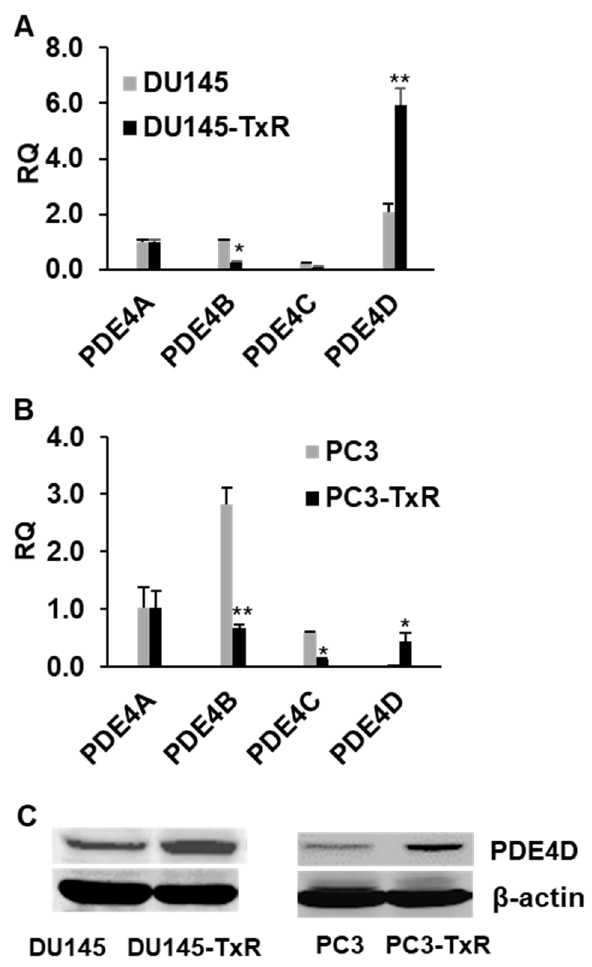
Figure 1. PDED4 expression is highly upregulated in chemo-resistant prostate cancer cells. ( A ) and ( B ) mRNA expression of all four PDE4 subtypes (PDE4A, PDE4B, PDE4C and PDE4D) was examined by RT-PCT in the chemo-sensitive prostate cancer DU145 and PC3 cells and the chemo-resistant prostate cancer DU145-TxR and PC3-TxR cells. The result showed that only PDE4D expression was highly upregulated in the chemo-resistant prostate cancer cell lines. RT-PC result was represented as mean relative quantity (RQ) ± SEM ( n = 3, * p < 0.05, ** p < 0.01). ( C ) Western blotting result confirmed that PDE4D expression was elevated in the chemo-resistant prostate cancer DU145-TxR and PC3-TxR cells in comparison to the chemo-sensitive prostate cancer DU145 and PC3 cells.